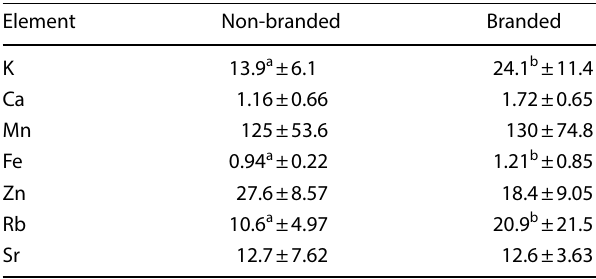
Table 2 Differences in mean concentrations of elements between branded and non-branded turmeric samples from East African mar- kets. K, Ca and Fe are reported in g kg −1 and values are given in mg kg −1 for Mn, Zn, Rb and Sr